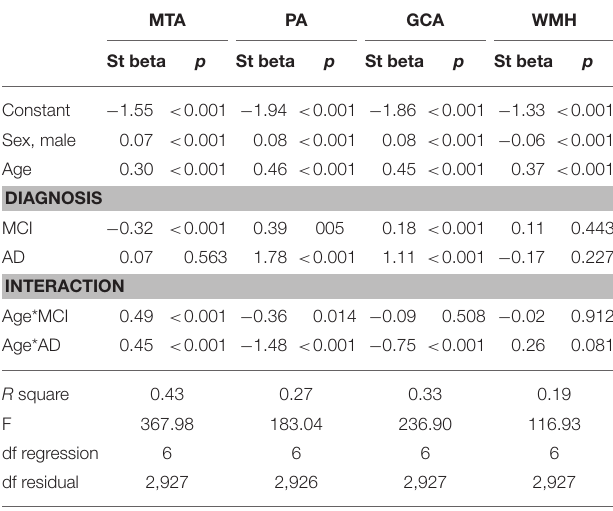
Linear regression analyses were used, using separate models for each rating scale. As independent variables we entered diagnosis (using dummy variables), age (continuous) and the interaction terms for age * diagnosis. St beta: standardized coefficients beta, p, p-value; F, Fisher; df, degrees of